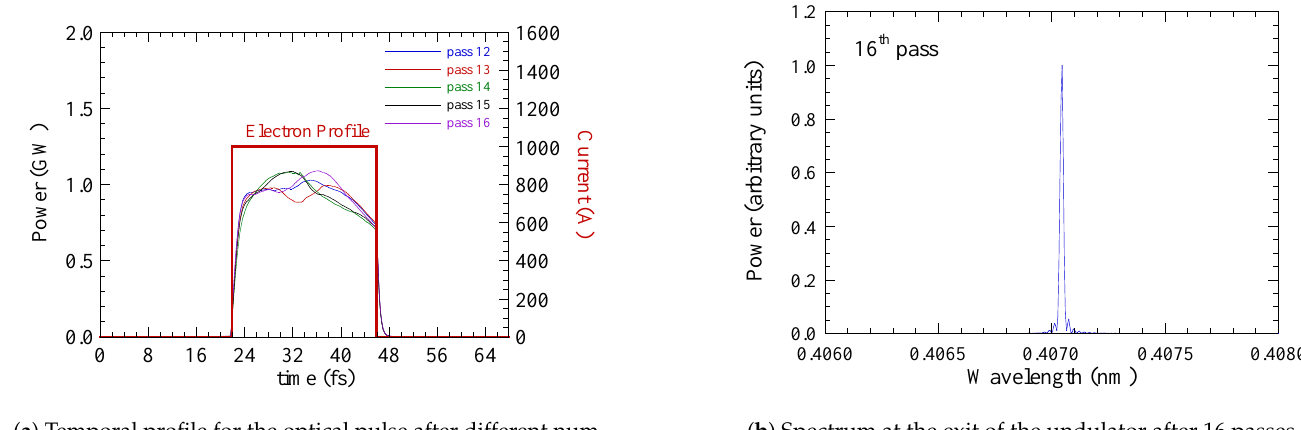
( a ) Temporal profile for the optical pulse after different num- ber of passes and current pulse (red). Figure 27. Temporal pulse shape for the electron bunch and optical pulse after different number of passes and the spectrum at pass number 16 of the optical pulse at the exit of the undulator. Other parameters as described in the text. The narrow relative linewidth in this regime of about 7.3 × 10 − 5 at the undulator exit, as shown in Figure 27b after pass 16, as well as the smooth temporal profiles shown in Figure 27a, are associated with longitudinal coherence after saturation is